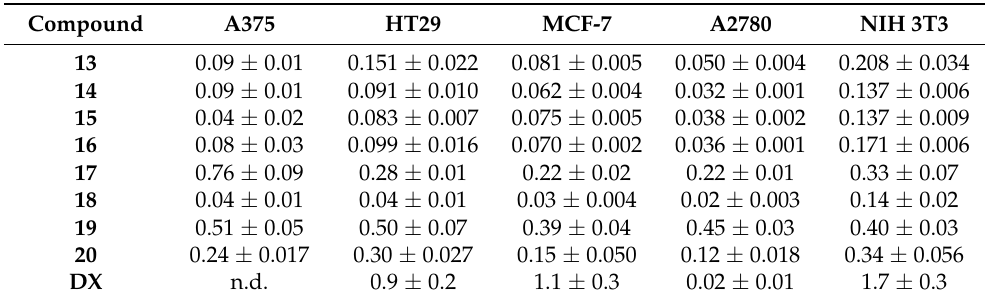
Table 3. Cytotoxicity of 3- O -acetylated triterpenoic amides holding a distal rhodamine B unit 13 – 20 (EC 50 -values in µ M from SRB-assays) after 72 h of treatment; the values are averaged from three inde- pendent experiments performed each in triplicate, confidence interval CI = 95%; mean ± standard mean error); n.d. not determined; n.s. not soluble; doxorubicin ( DX ) was used as a positive control. Cell lines: malignant: A375 (melanoma), HT29 (colon adenocarcinoma), MCF-7 (breast adenocarci- noma), A2780 (ovarian carcinoma); non-malignant: NIH 3T3